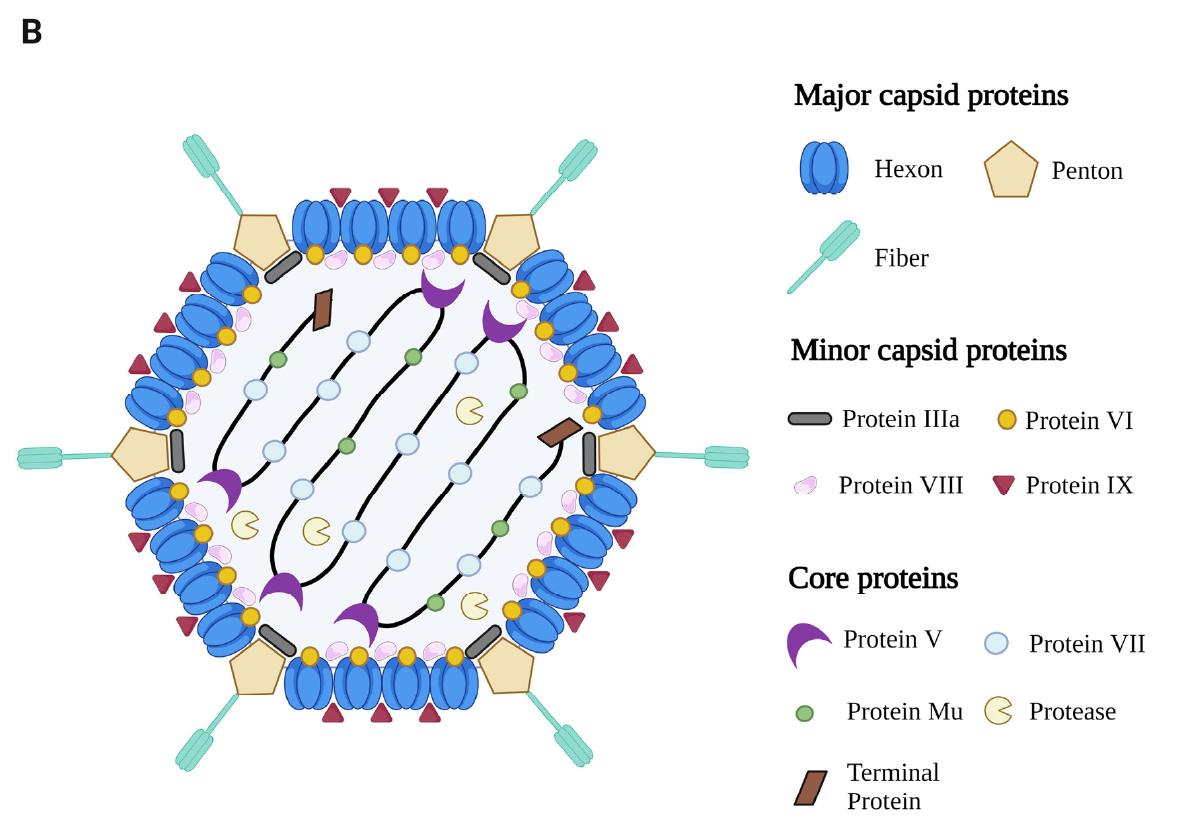
Figure 1. Genome organization and structure of human adenovirus type 5. ( A ) Schematic representa- tion of the adenoviral genome, transcription units, and major proteins. ( B ) Structural representation of adenovirus and its components. E, early region (shown as red arrows); L, late region (shown as black arrows); L’-ITR, left inverted terminal repeat; R’-ITR, right inverted terminal repeat; Ψ , packaging signal; AdPol, adenovirus DNA polymerase; TP, terminal protein; DBP, DNA-binding protein.